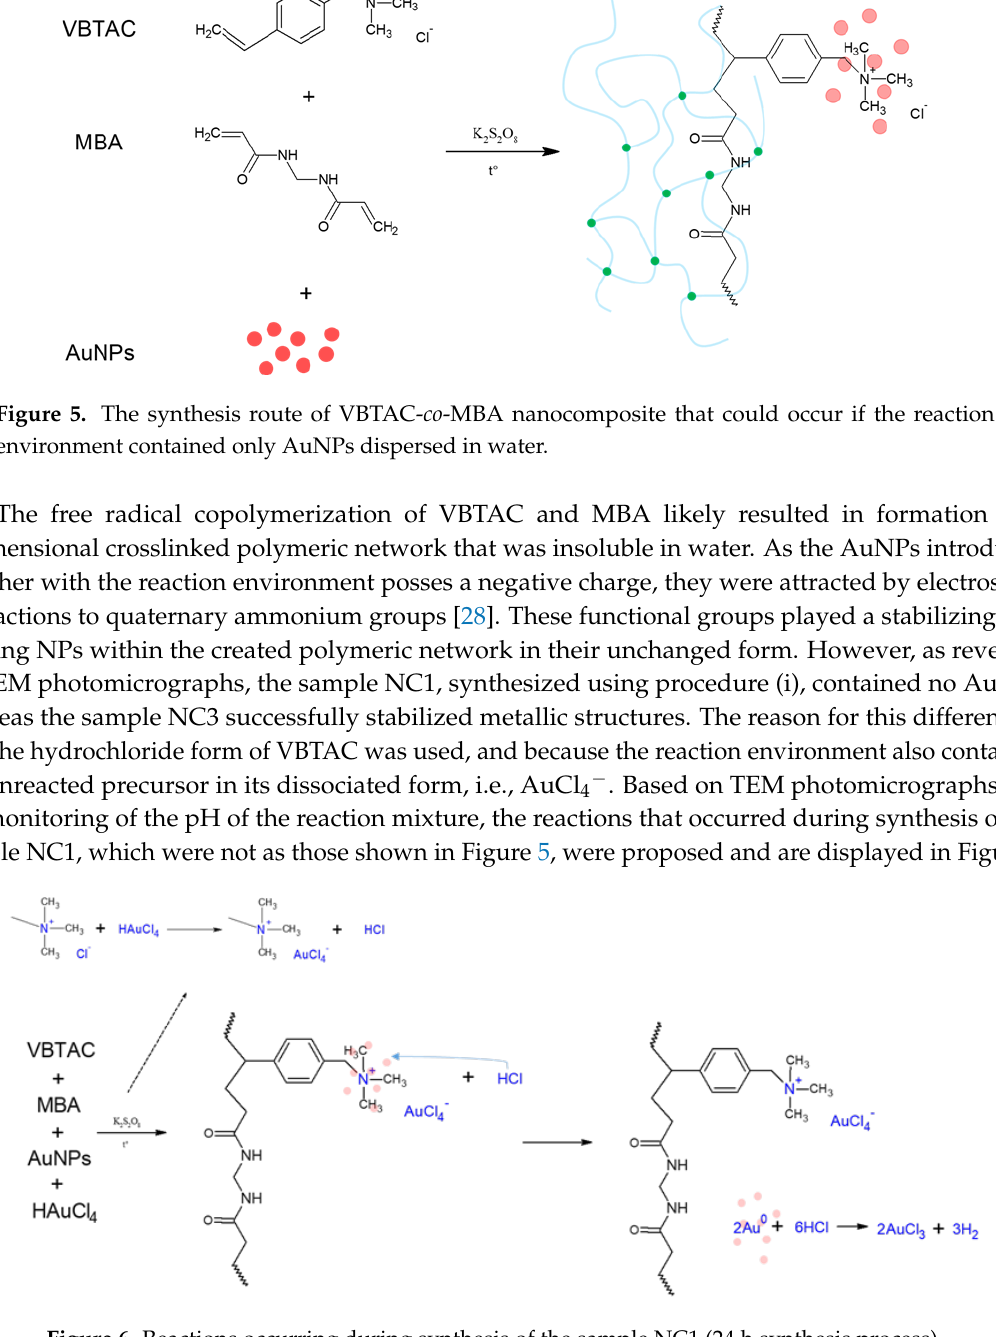
Figure 6. Reactions occurring during synthesis of the sample NC1 (24 h synthesis